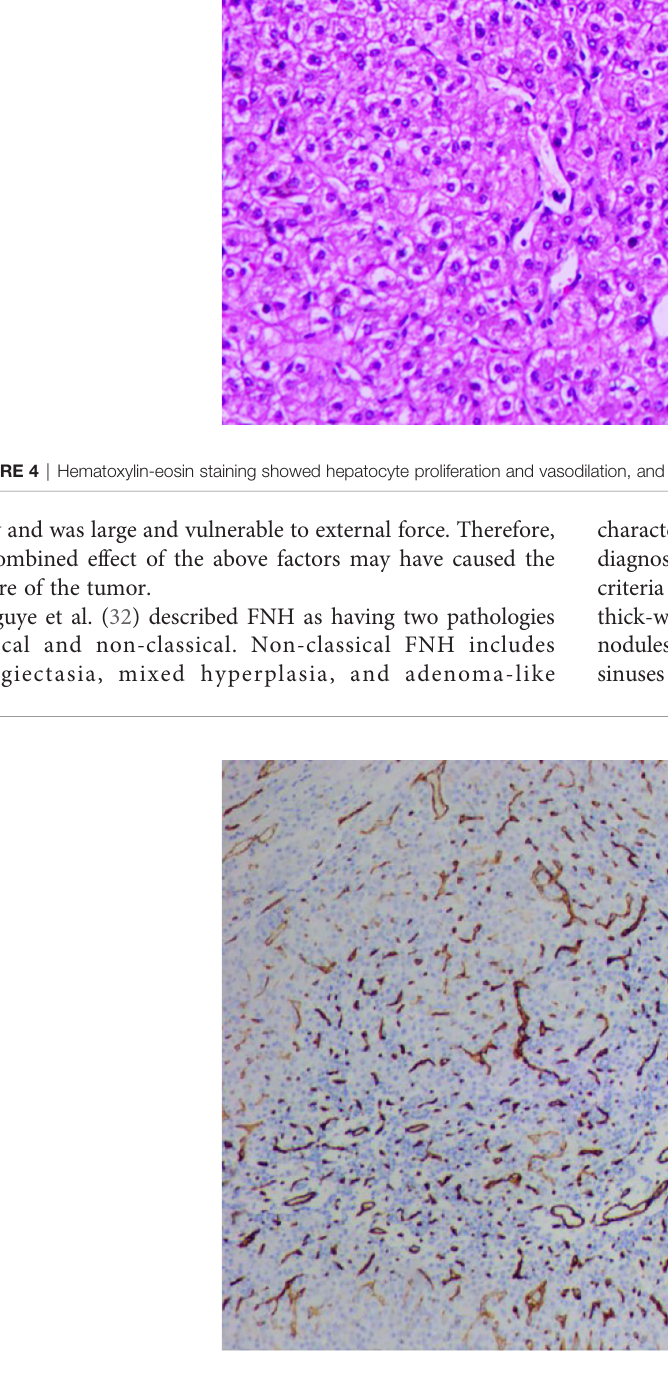
FIGURE 5 | Immunohistochemistry showed CK19 (focal +).